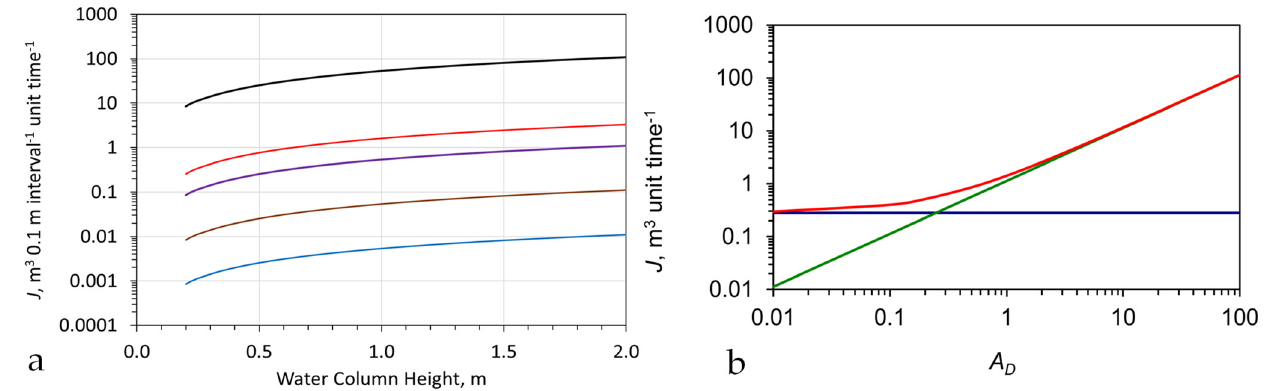
Figure A20. Impact of anisotropy. ( a ), Horizontal infiltration rate, per 0.1 m interval, versus water column height. k v = 0.09 m 3 m 2 unit time − 1 ; blue line: A D = 0.1; brown line: A D = 1.0; purple line: A D = 10; red line: A D = 30; Black line: A D = 100; ( b ), infiltration rate versus anisotropy ( A D ). Blue = infiltration through base of infiltration device (3.14 m 2 ); Green = infiltration through sides of the infiltration device (6.28 m 2 ); Red = total infiltration; constant average water depth in the infiltration device = 2 m.